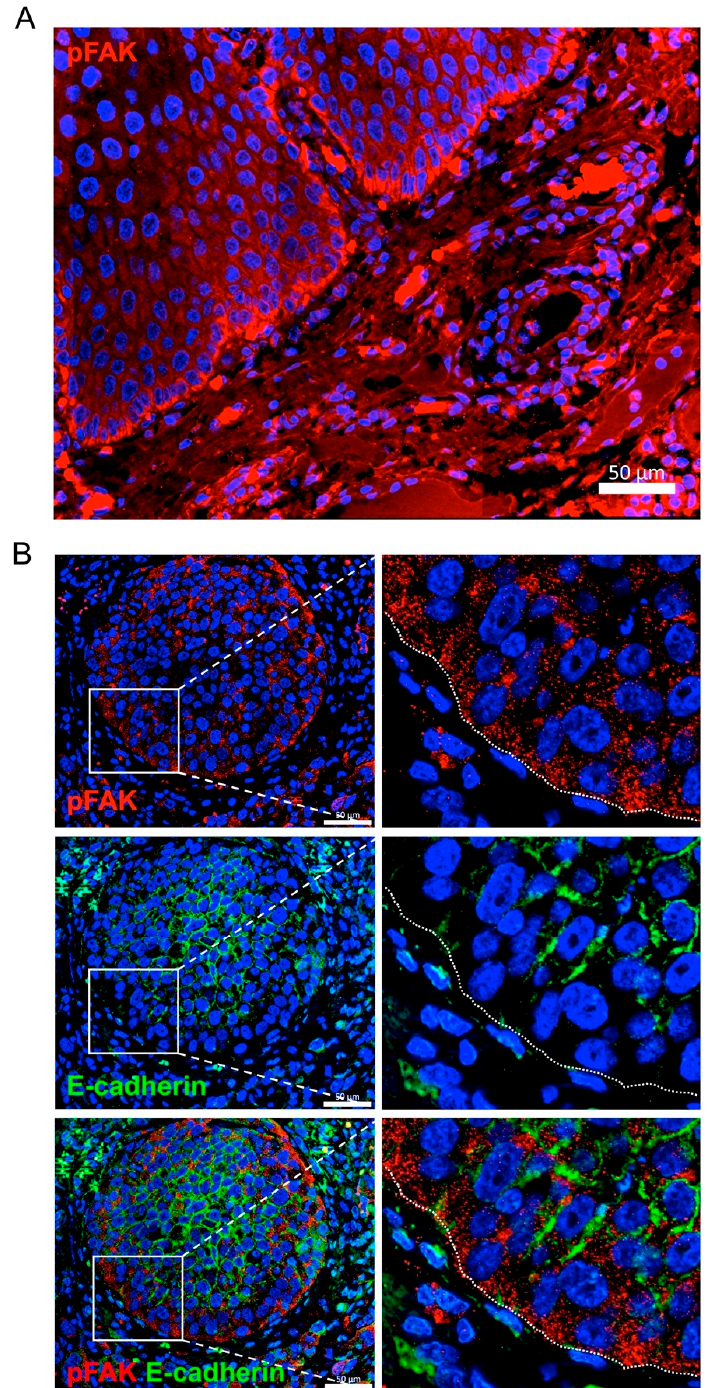
Figure 9. pFAK is highly expressed at the borders of cancer cell nests matching with areas of loss of E-cadherin expression. ( A ) Representative image of pFAK immunofluorescence in head and neck SCCs showing high expression levels at the border of the tumor. ( B ) Double immunofluorescence labeling of a head and neck SCC tissue for E-cadherin (red) and pFAK (red) showing that pFAK is predominantly expressed at the border of the cell nest where E-cadherin is lost. Insets show the boundary between the tumor nest and the surrounding stroma (dashed white line). Scale bars, 50 µm.